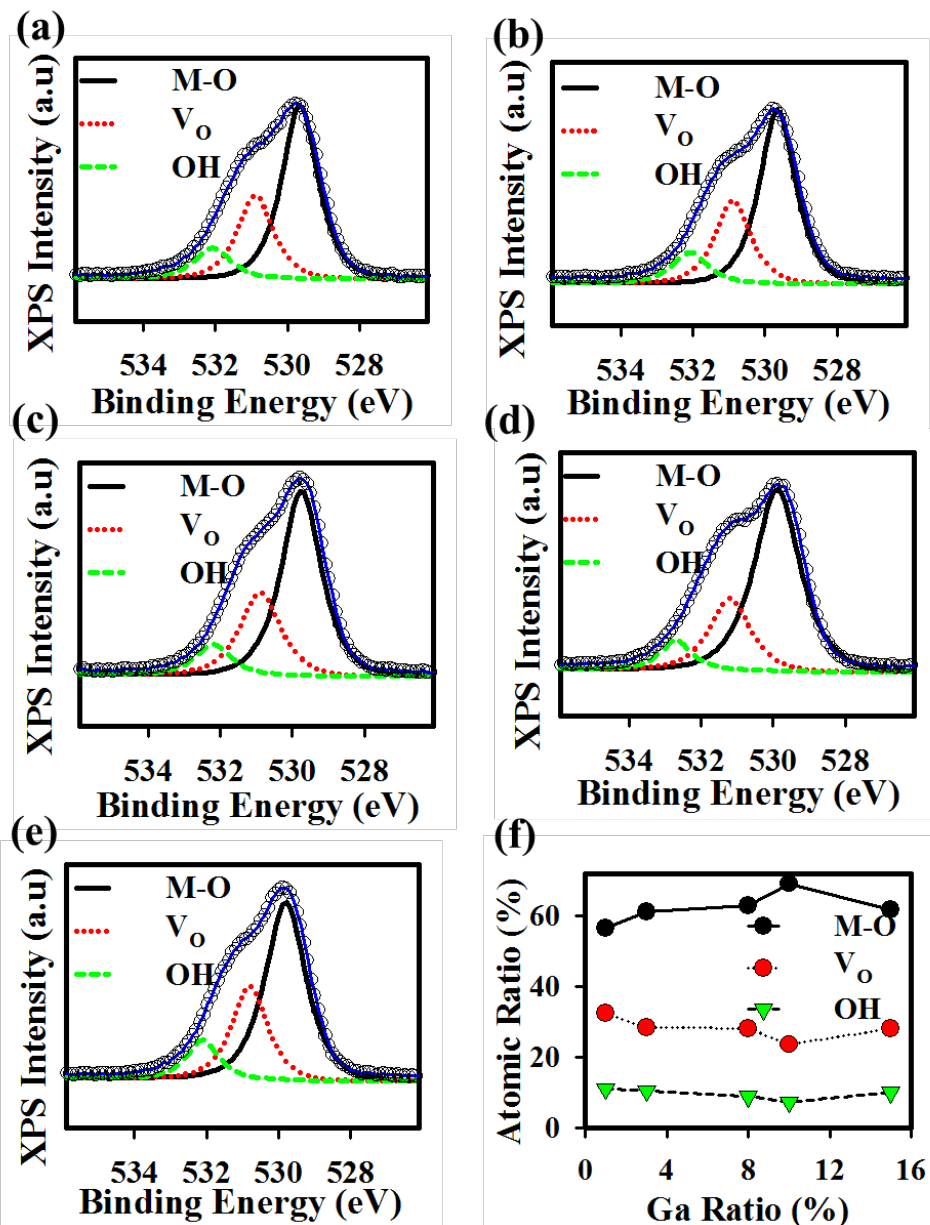
Figure 4. ( a – e ) Deconvoluted O1s binding energy spectra for spray pyrolyzed IGTO film deposited at a substrate temperature of 350 °C, where Ga ratio varied from 1 to 15%. ( f ) The atomic ratios of M-O, V o , and -OH in IGTO films. The M-O bond ratio increases by Ga concentration until 10%.